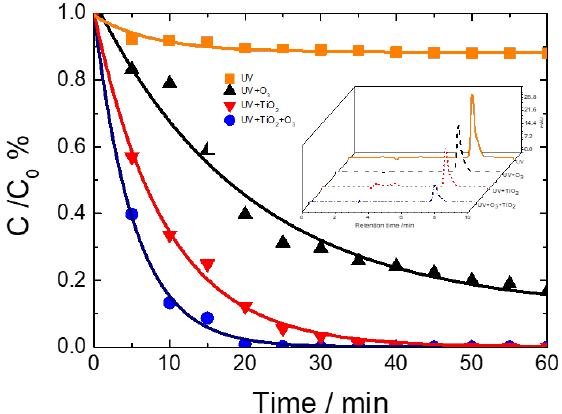
Figure 3. Imazapyr degradation as a function of time by several oxidative chemical processes: photolysis, ozonation, photocatalysis and photocatalytic ozonation. C (Imazapyr) = 5 µ M; stirring speed = 1000 min −1 , TiO 2 = 50 mg, pH 7.